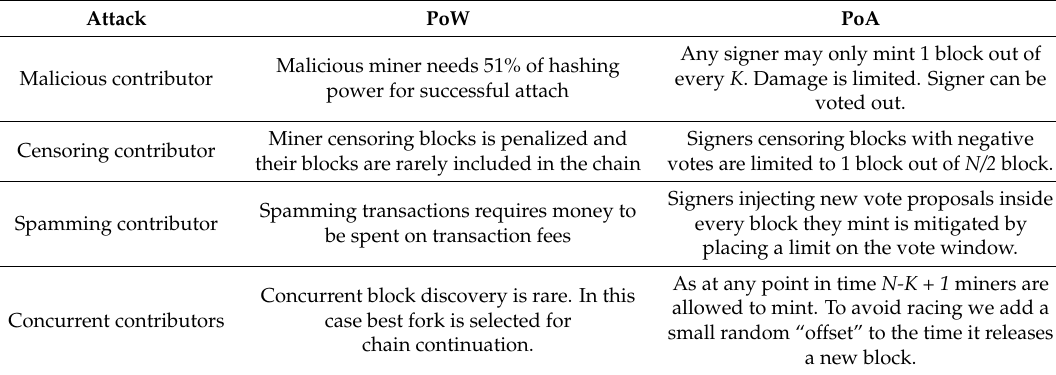
Table 2. Solution to attack methods in PoW and